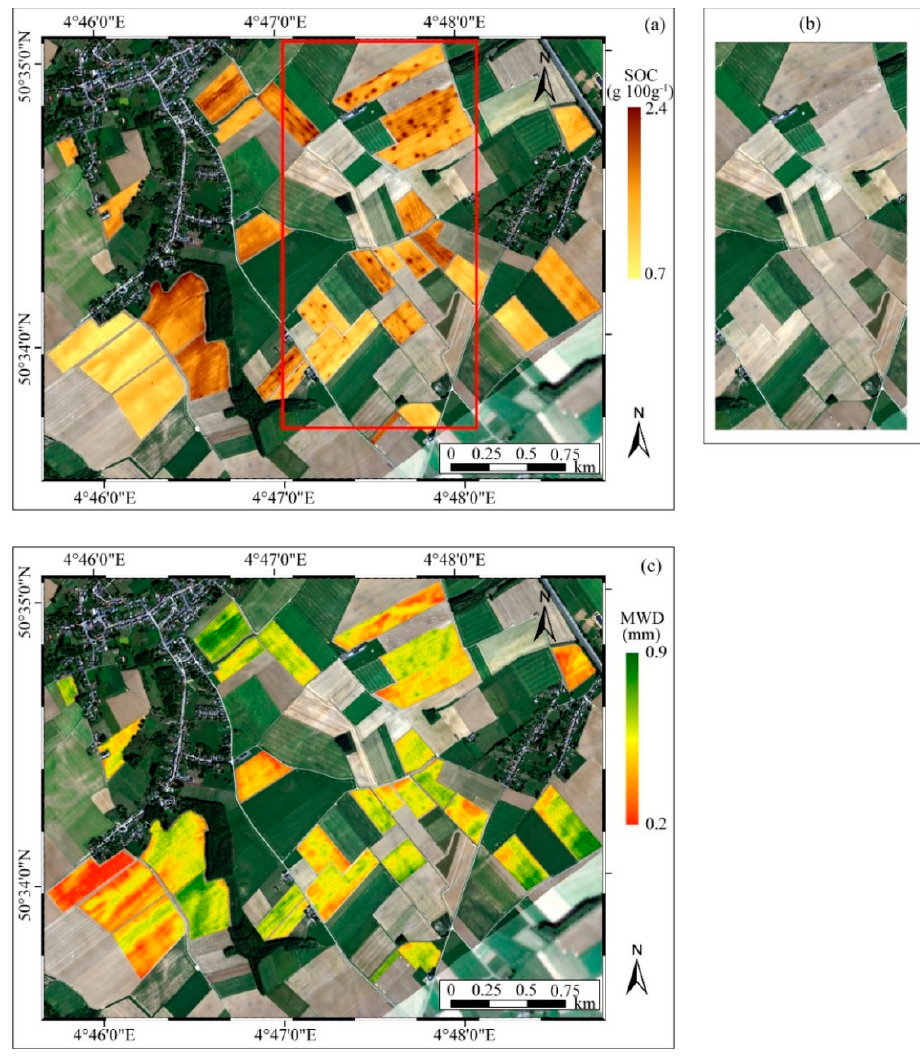
Figure 7. Zoom on a selected area of the ( a ) SOC map, ( b ) RGB image of a confined area shown by the red rectangle in ( a ), and ( c ) MWD map. SOC and MWD maps were produced by applying the PLSR models to the bare soil fields. The red square in the south-west corner of the map in Figure 1 gives the position of the selected area.